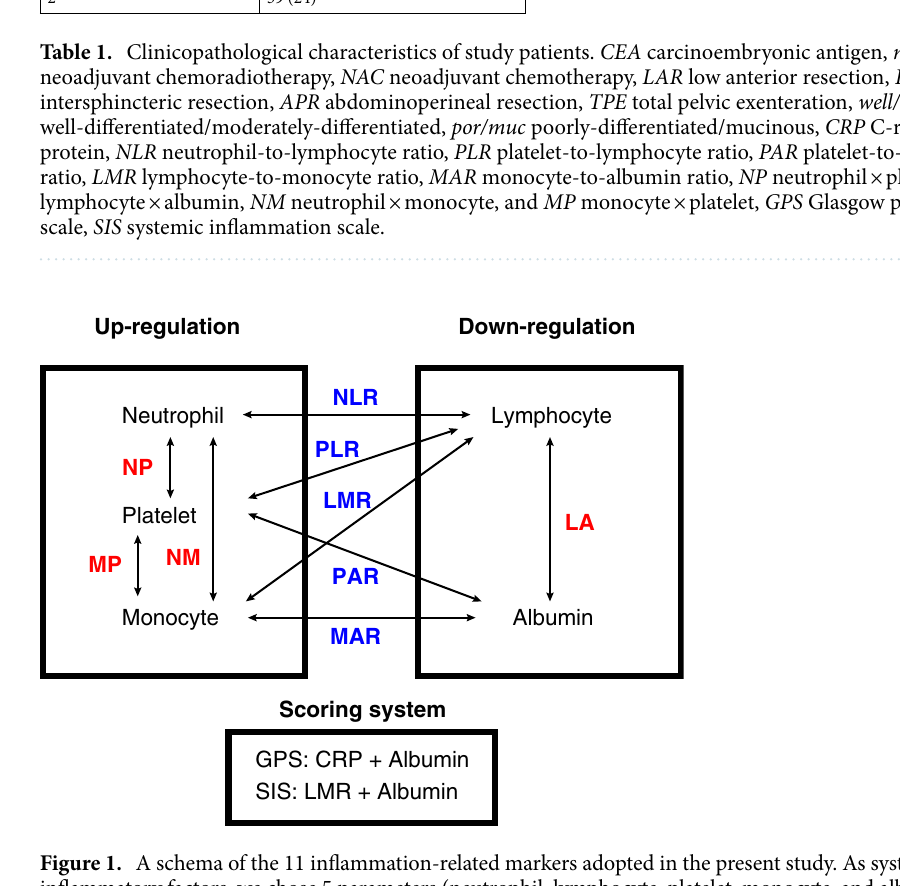
Figure 1. A schema of the 11 inflammation-related markers adopted in the present study. As systemic inflammatory factors, we chose 5 parameters (neutrophil, lymphocyte, platelet, monocyte, and albumin). The combination of each parameter (i.e., a total of 9 possible combinations) as well as two established inflammation- related scoring systems (i.e., GPS and SIS) were